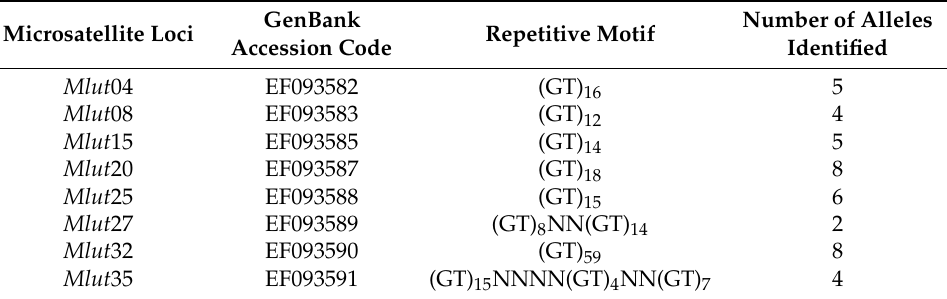
Table 1. Microsatellite loci identified for Mustela lutreola by Cabria et al.